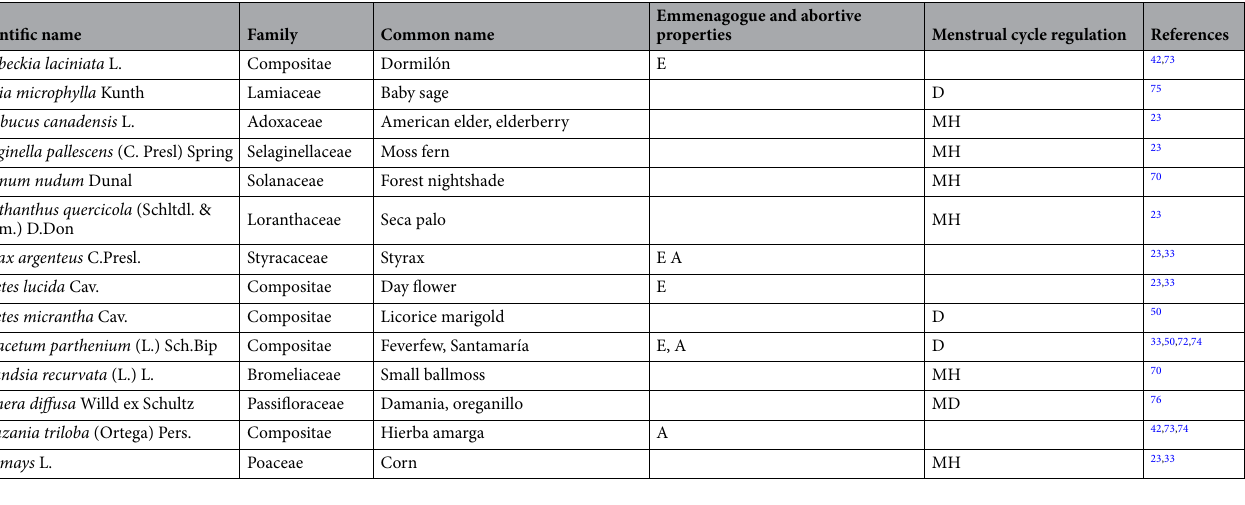
Table 1. Plants used in Mexican traditional medicine with emmenagogue and abortive properties, or used to treat menstrual cycle disorders. A abortifacient, E Emenagogue, MH Menstrual hemmorage, D dysmenorrhea, NS. Non specified, M menorrhagia, IP induces menstrual period, MD Menstrual disorders